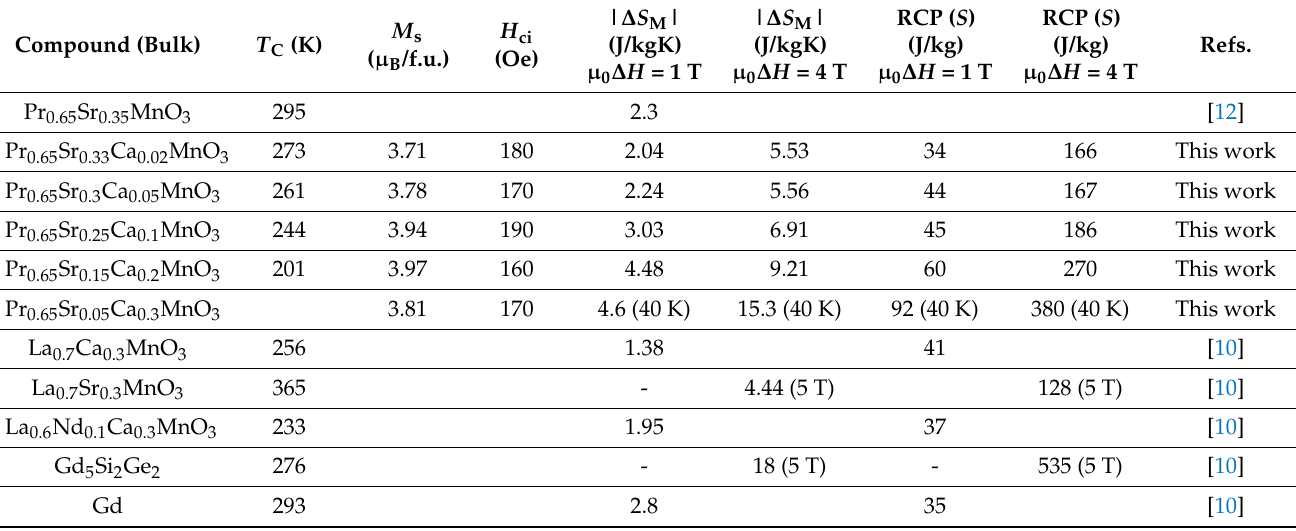
Table 6. Experimental values for Pr 0.65 Sr 0.35 − x Ca x MnO 3 bulk materials: magnetic